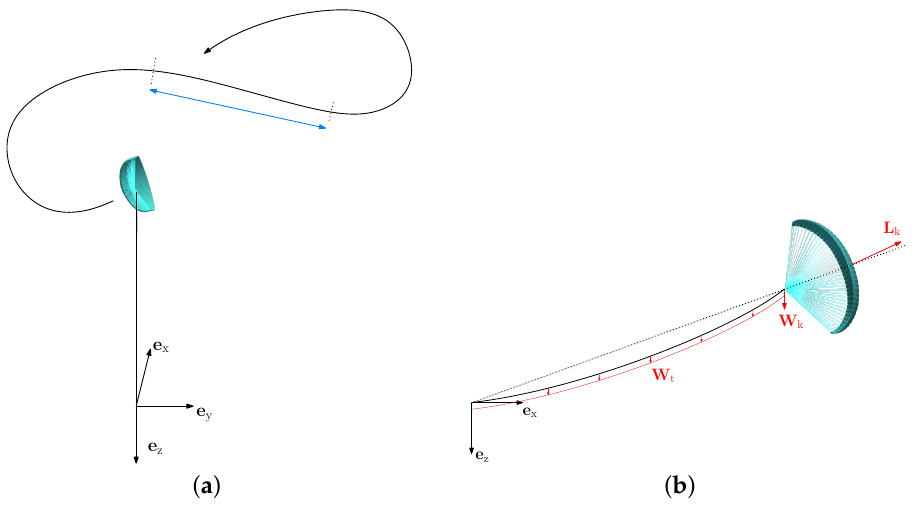
Figure 1. Model simplification for the virtual wind tunnel [20]. ( a ) Kite performing figure-eight maneuvers during the power phase. On the indicated, roughly straight trajectory segment, no steering input is given and the parafoil flies at a constant speed. ( b ) Effect of kite weight and tether sag due to the gravity during the power